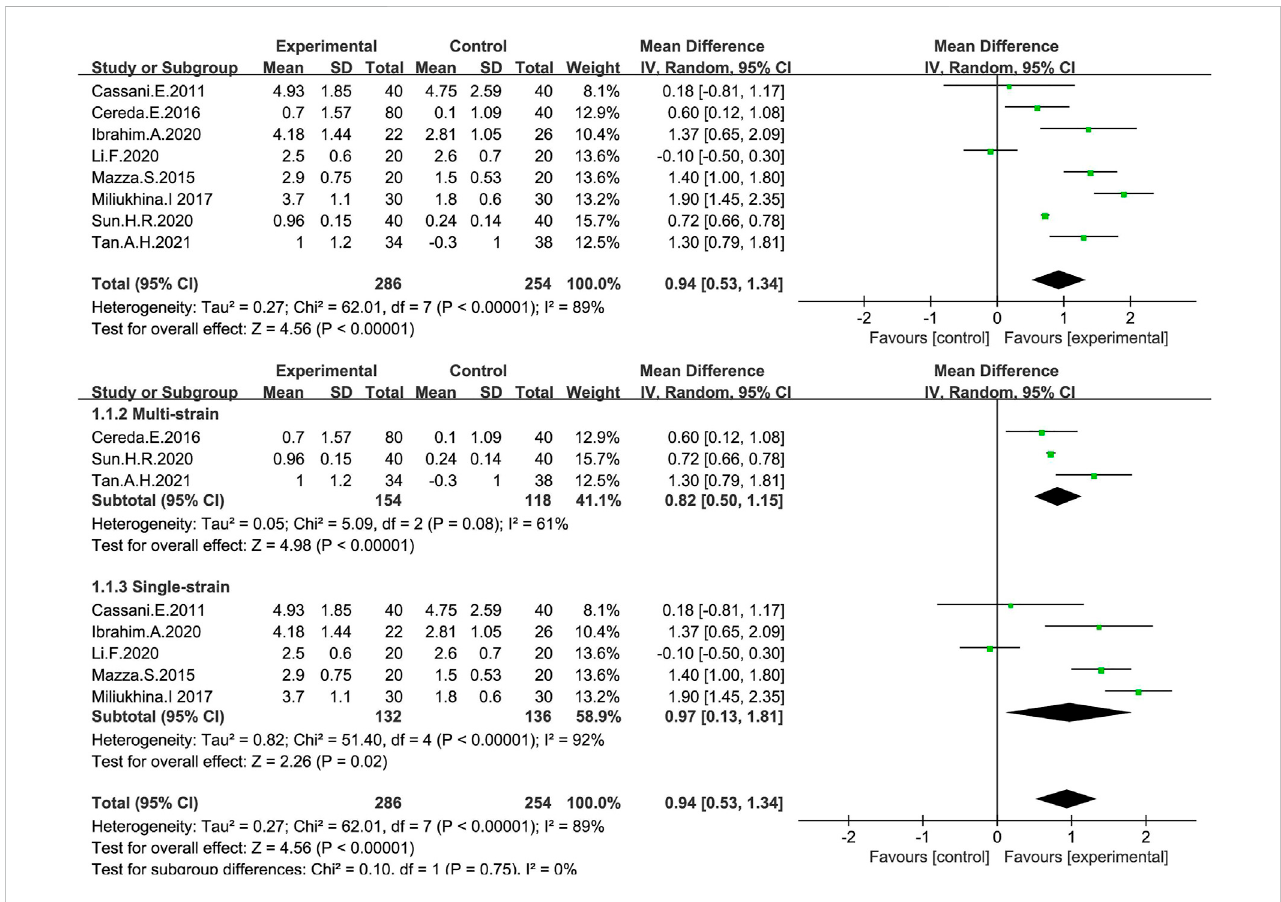
FIGURE 3 Forest plot of Stool frequency in the probiotic intervention group versus that of the control group with MD and a 95% CI analysis using arandom-effects effect model.